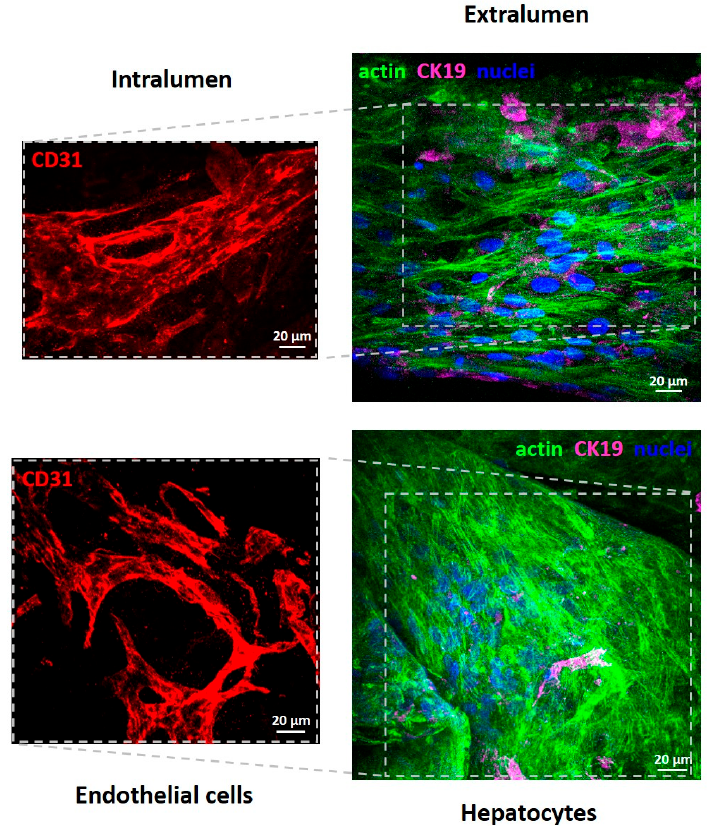
Figure 6. Confocal Laser Scanning Microscopy (CLSM) images of primary human hepatocytes and human endothelial cells after 18 days of culture in PCL HF membrane bioreactor. Endothelial cells in the intraluminal compartment were visualized for CD31 (red); hepatocytes over and between the fibers in the extraluminal compartment were stained for actin (green), CK19 (magenta), and nuclei (blue).